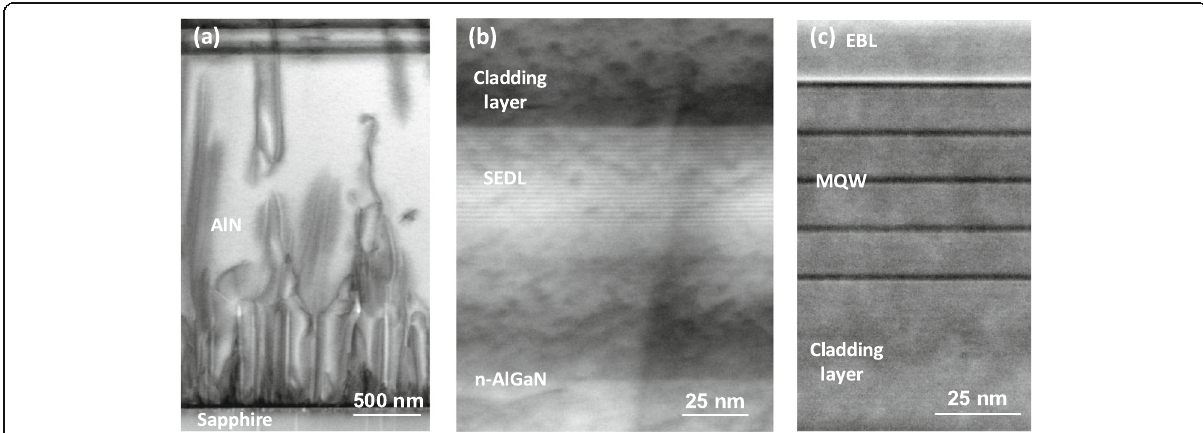
Fig. 2 Morphology characterization of typical sample B. a Cross-sectional STEM image of the AlN template. b Cross-sectional STEM image in the region of 20 periods of SEDL. c Cross-sectional STEM image in the active region